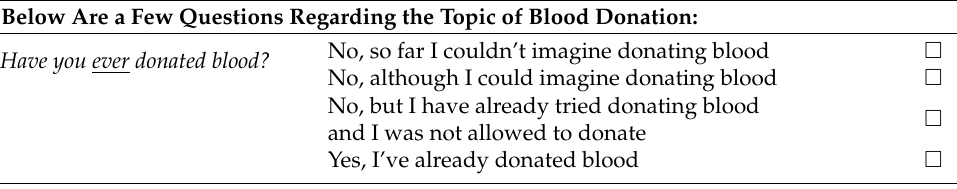
Table A1. Questionnaire assessing self-reported retrospective and prospective blood donation behaviour as well as corresponding blood donation motivators and